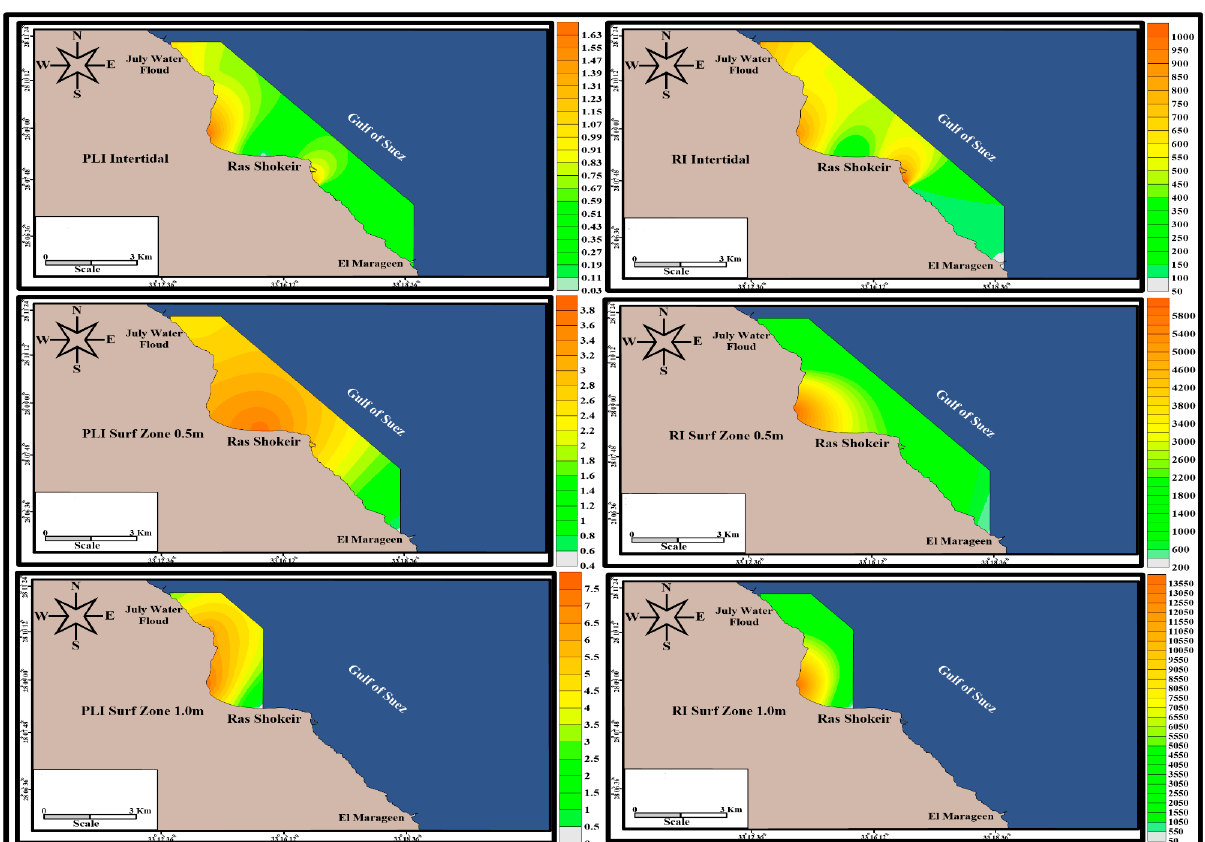
Figure 5. Spatial distribution for the pollution load index (PLI) and the potential ecological risk index (RI) at Ras Shokeir.